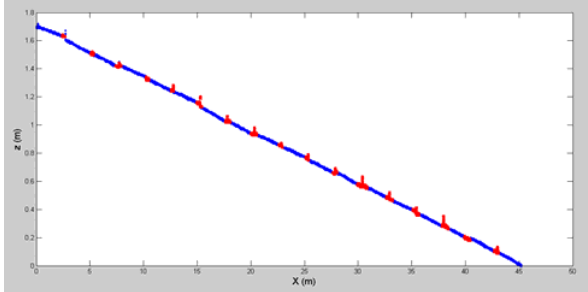
Figure 6. Scheme of transversal (blue) and longitudinal (red) profiles extracted from the point cloud to evaluate the geometric deformations. Figure 7 exhibits the results of a transversal profile. The joining points between the voussoirs are red highlighted. The maximum deformation founded is 5 mm. Figure 8 exhibits the analogous longitudinal profile. In this case, deformations are undetectable.